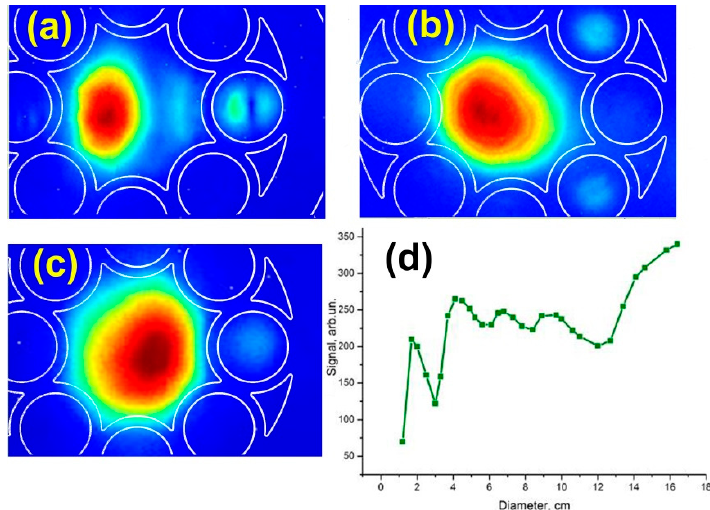
Figure 6. The experimentally measured intensity distributions of the hollow core modes arising at the bending of the RF; white lines show a RF cross-section contour. Intensity distributions are shown for: ( a ) RF bend diameter of 1.6 cm; ( b ) bend diameter of 3.6 cm; ( c ) bend diameter 5.6 cm; ( d ) The experimental dependence of the light intensity transmitted through the RF vs. bend diameter of the fiber